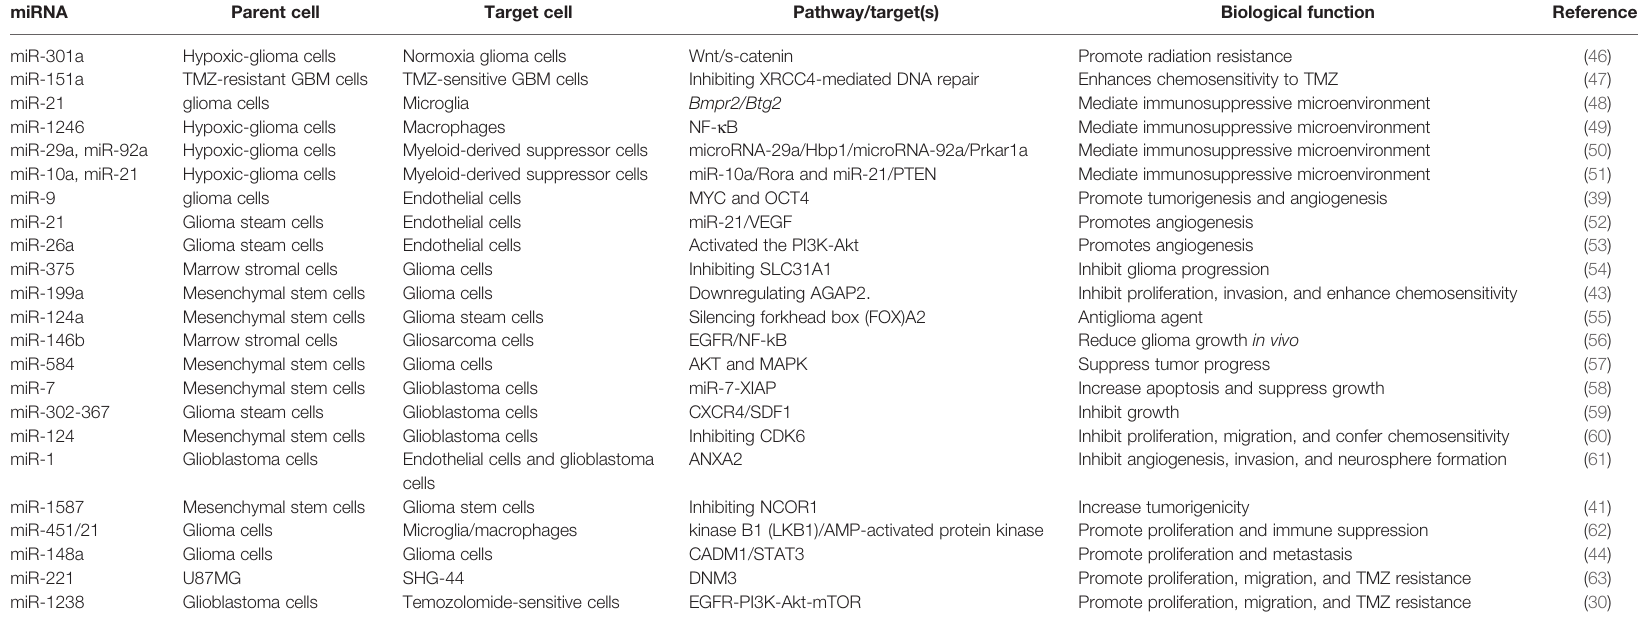
TABLE 1 | The biological functions of exosomal miRNAs in